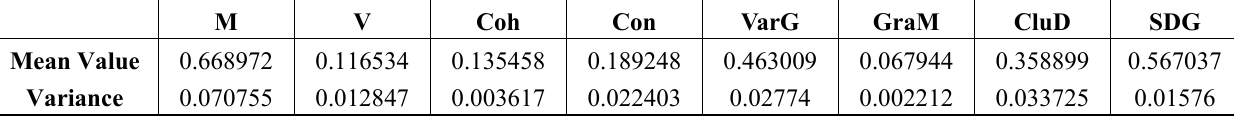
Table 2. The mean value and variance of segmentation error rate.